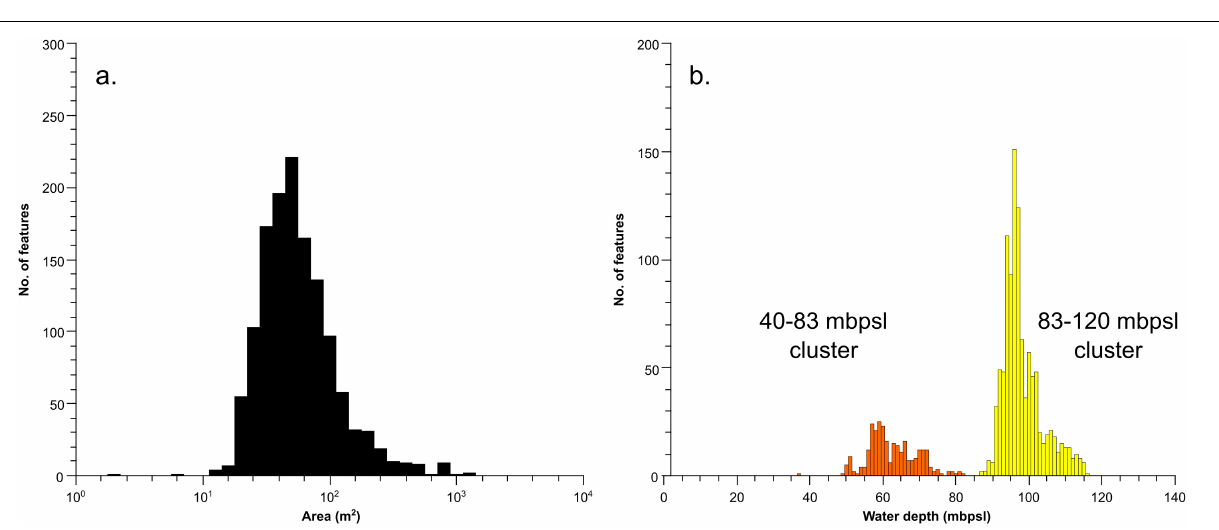
FIGURE 3 | Histograms of (a) area, (b) water depth of the base of the